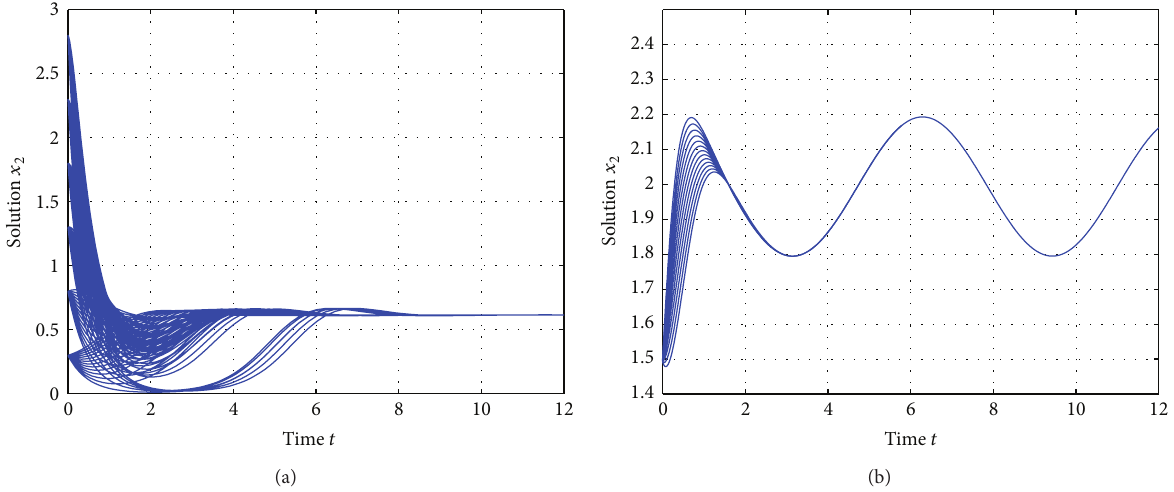
Figure 5: The trajectory of the prey 𝑥 2 of model (30) with (a) 𝑏 1 = 3.0 and 𝜏 = 0 ; (b) 𝑏 1 = 3.0 , 𝜏 ̸=0 , and 𝑥 𝑑 = (2.5+0.2 sin (𝑡),2.0+0.2 cos (𝑡)) .